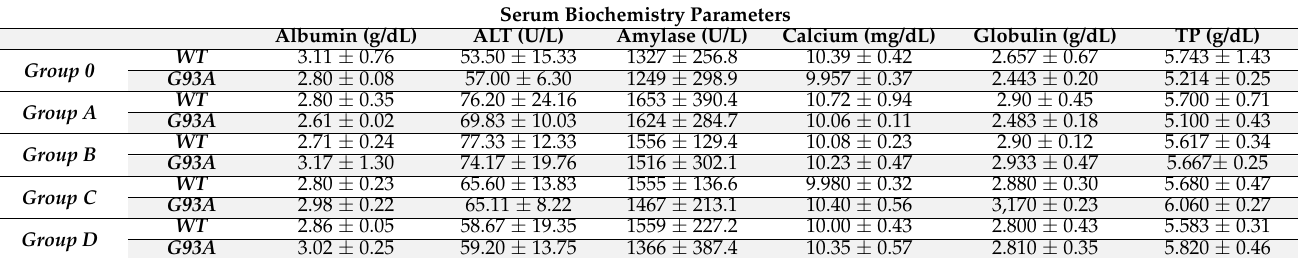
Table 2. Serum levels of albumin, alanine transaminase (ALT), amylase, calcium, globulin, and total protein (TP) in the SOD1 WT and SOD1 G93A rats, given as mean ± SD of n = 7 animals for each group. Serum Biochemistry Parameters Albumin (g/dL) ALT (U/L) Amylase (U/L) Calcium (mg/dL) Globulin